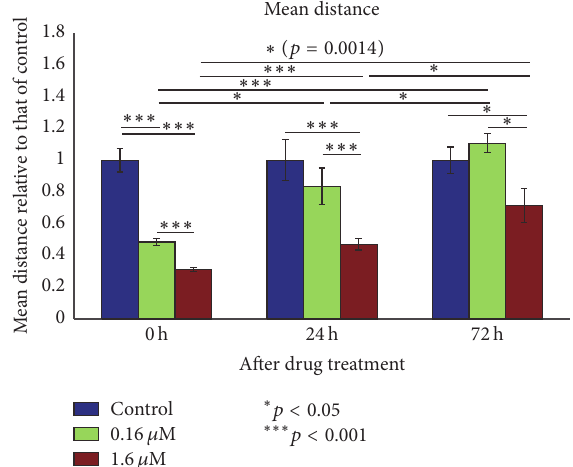
Figure 5: Startle response of fish larvae with neomycin treatment of different level of concentration and subsequent recovery period after drug removal. Mean moving distance after sound stimulation was used as the quantification parameter. To eliminate the variation of different days, the values are scaled by that of the control group in each day. The value in each column from left to right is 1 ± 0.23 , 0.48±0.06 , 0.31±0.03 , 1±0.41 , 0.84±0.36 , 0.47±0.11 , 1±0.27 , 1.10 ± 0.19, or 0.72 ± 0.34 in the format of mean ± standard deviation. The unpaired t -test on adjacent columns in each day is shown to be mostly significant, except for between control and 0.16 𝜇 M at 24 h or at 72 h. For the same drug concentration (e.g., 0.16 𝜇 M at 0 h, 24 h, and 72 h), unpaired t -test shows significant ( 𝑝 < 0.05 ) difference between days for both 0.16 and 1.6 𝜇 M